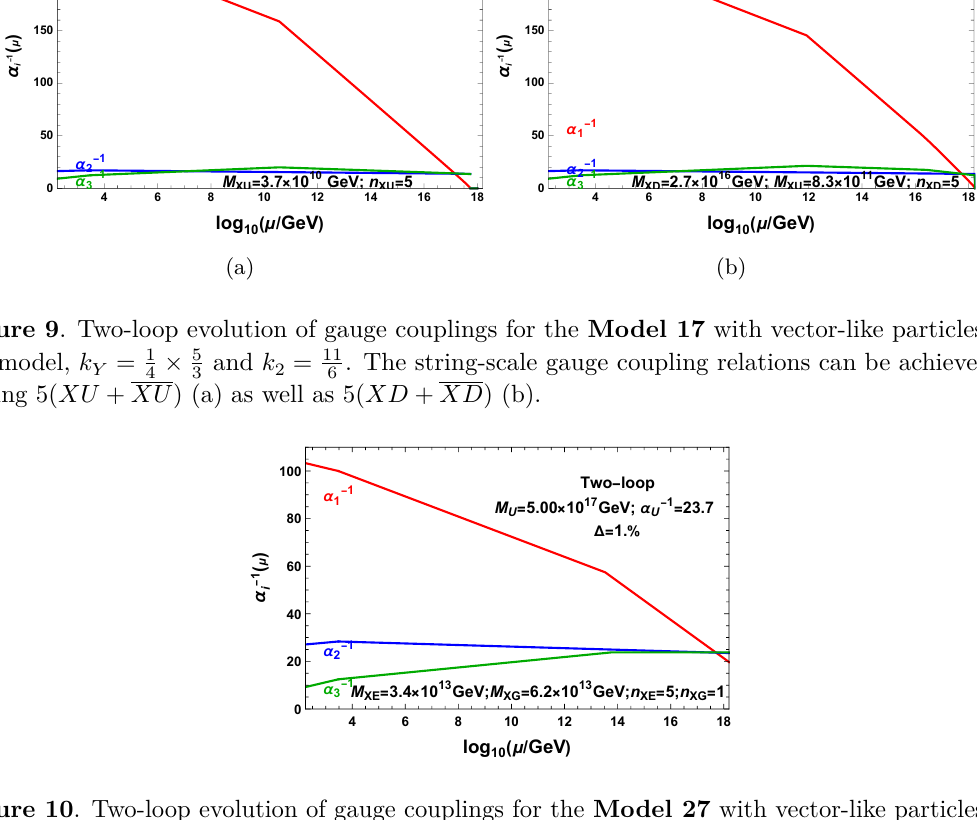
Figure 10 . Two-loop evolution of gauge couplings for the Model 27 with vector-like particles. In this model, k = 4 × 5 and k = 10 . The string-scale gauge coupling relations can be achieved by Y 2 9 3 9 adding 5( XE + XE ) + XG around 10 13